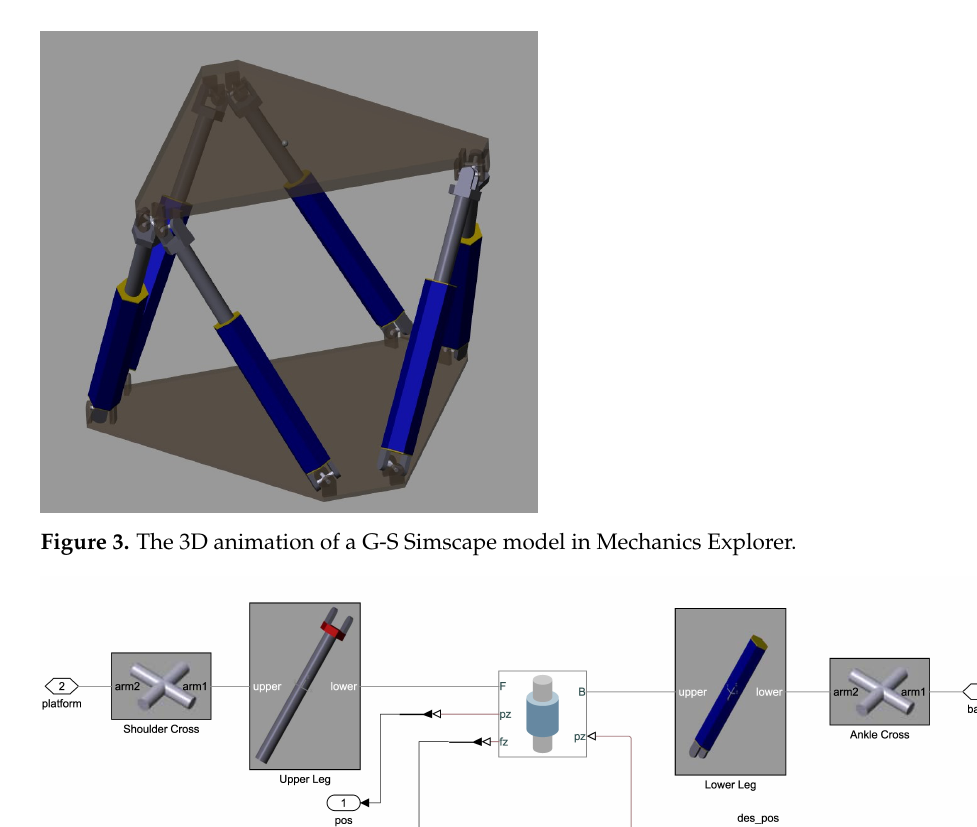
Figure 2. The Simscape model structure of a G-S platform.